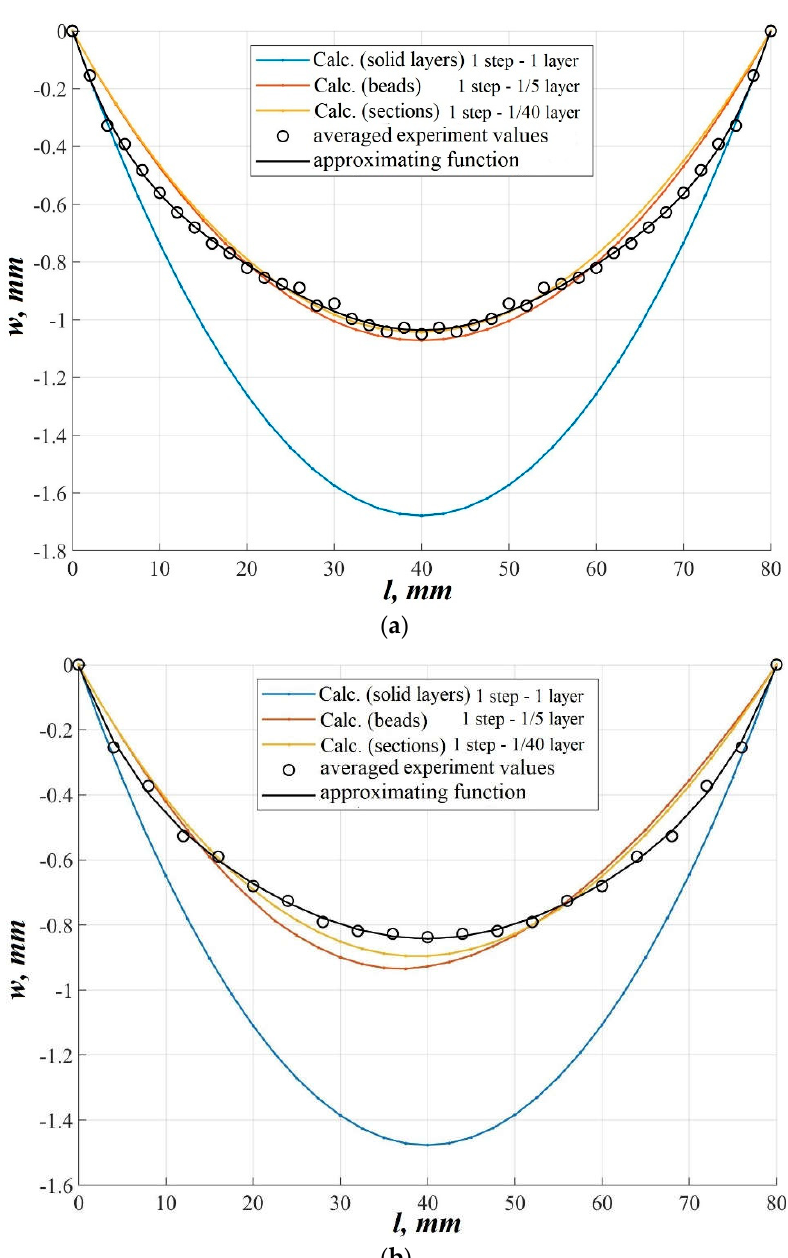
Figure 16. Residual bending of the sample after its separation from the platform in three numerical solutions and a full-scale experiment: ( a ) for samples with a longitudinal laying of the material; ( b ) for samples with a transverse laying of the material. The graphs show the value of the deflection (w) along the length (l) of the sample.